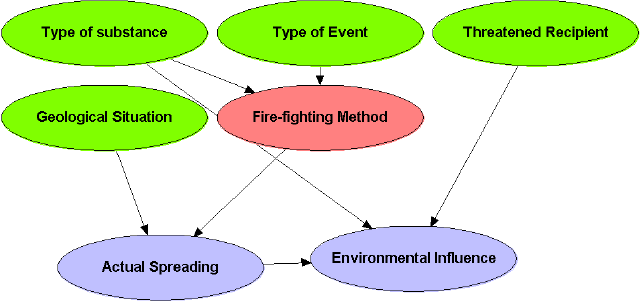
Figure 8: Causal network for the environmental impact of different fire-fighting